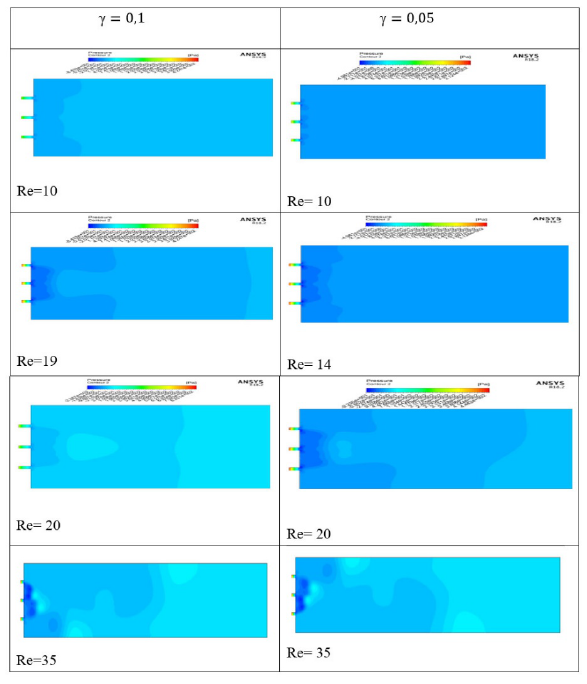
Figure 11: The pressure of flow for γ = 0.05, 0.1 in different Reynolds numbers for three jets